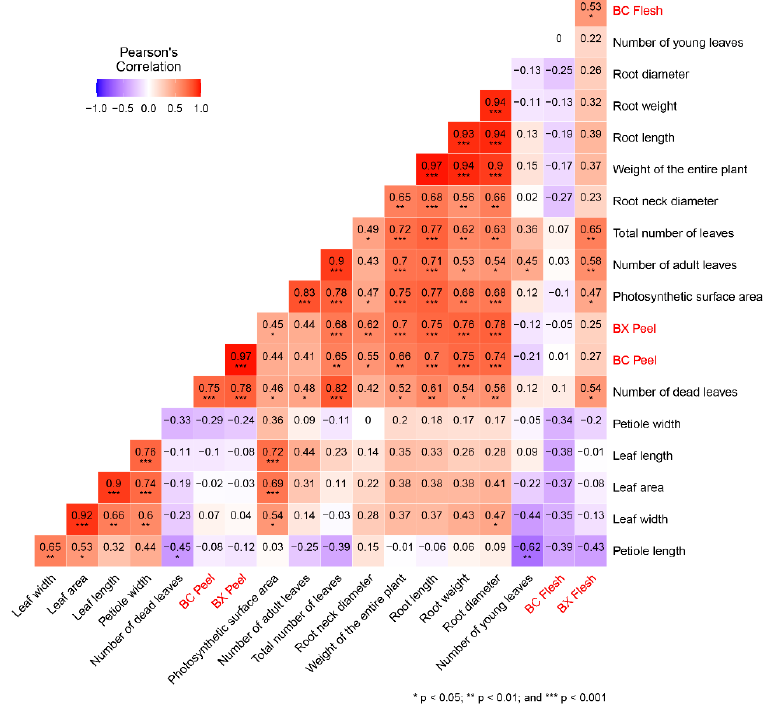
Figure 5. Correlogram showing the correlations between different morphological characters and table beet betalains in the yellow-colored group 3 ( n = 100 replications). The numbers inside each square show the Pearson R correlation values.